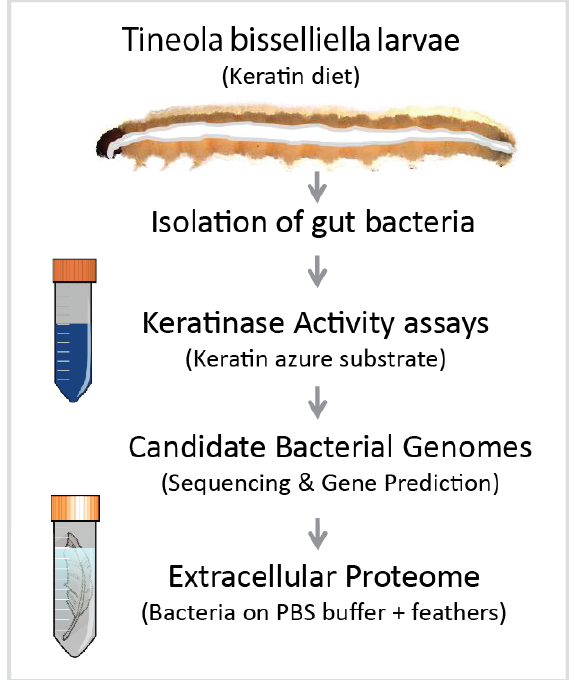
Figure 1. Experimental workflow for the identification of keratin-degrading proteins in bacteria associated with the clothing moth Tineola bisselliella . Clothing moth larvae were reared on a keratin-based diet for several generations before the isolation of gut bacteria. Individual bacterial colonies were then tested for keratinase activity using keratin azure as a substrate. DNA was extracted from two bacterial isolates showing the strongest activity in the keratin azure assay as well as the ability to grow on whole feathers as a sole nutrient source. The genome sequence was screened for protein-coding genes allowing the identification of candidate keratinases. Extracellular proteins isolated from the supernatant of bacteria grown on feathers as a sole nutrient source were analyzed by LC MS-MS.